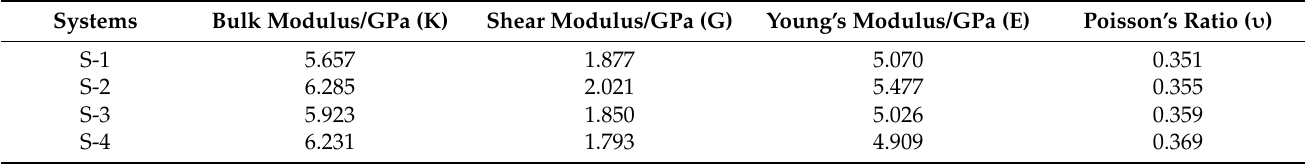
Table 1. The simulated mechanical properties of S-1, S-2, S-3 and S-4